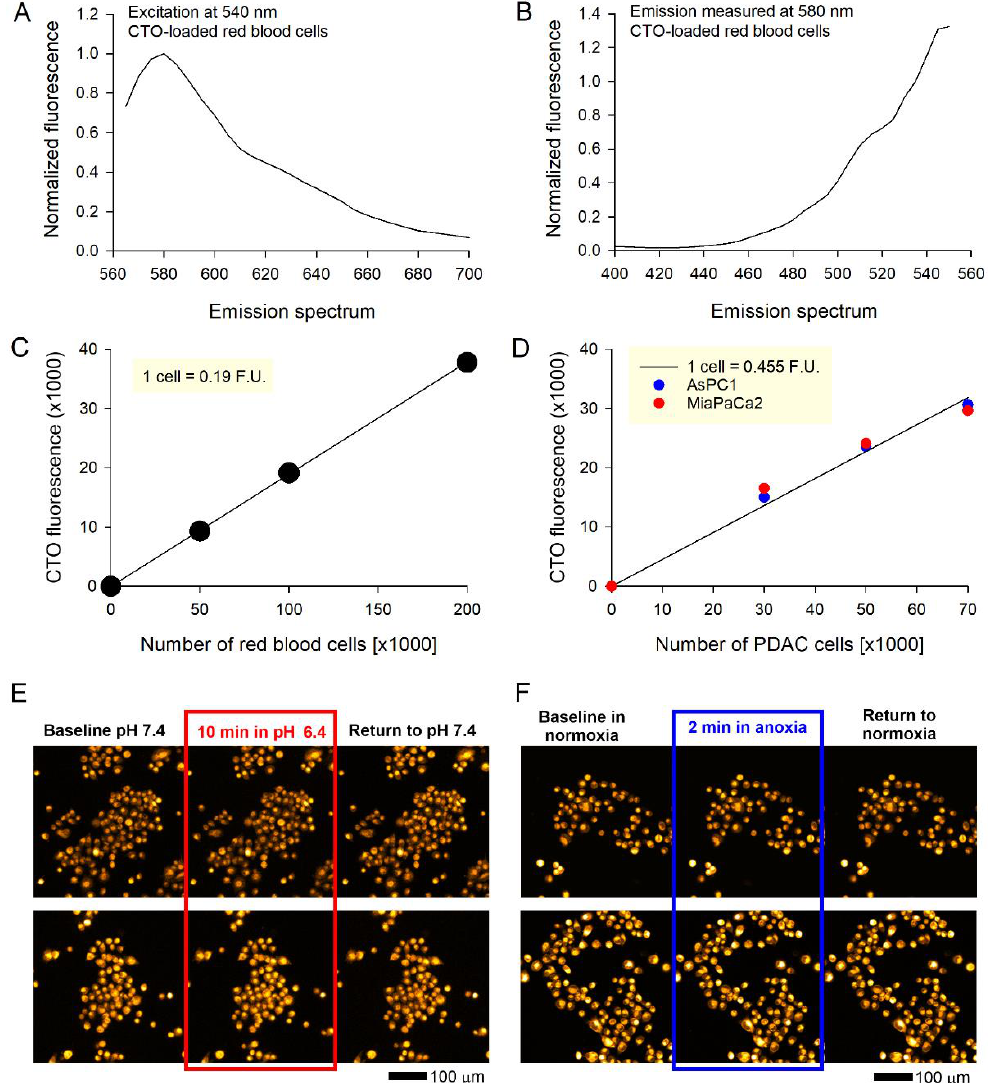
Figure 5. Using CellTracker Orange (CTO) to normalize for cell number. ( A ) The emission spectrum of CTO, excited at 540 nm. ( B ) The optimal CTO excitation is 540 nm, which ensures that the signal is resolvable from HPTS and RuBPY. ( C ) The correlation between CTO fluorescence and count of human red blood cells. ( D ) The correlating CTO signal with the number of plated AsPC1 and MIA-PaCa2 cells in wells of a 96-well plate. ( E ) Superfused MIA-PaCa2 cells imaged confocally. Fluorescence images taken during superfusion at pH 7.4 (baseline; 20 mM HEPES-buffered solution), after 10 min of superfusion at pH 6.4, and 10 min after returning to normal pH. Two exemplar experiments are shown. ( F ) Fluorescence images taken during superfusion in normoxic solution (baseline), after 2 min of superfusion in anoxic conditions (superfusate contained 1 mM dithionite, 100% N 2 ), and 2 min after returning to normoxia. Two exemplar experiments shown.